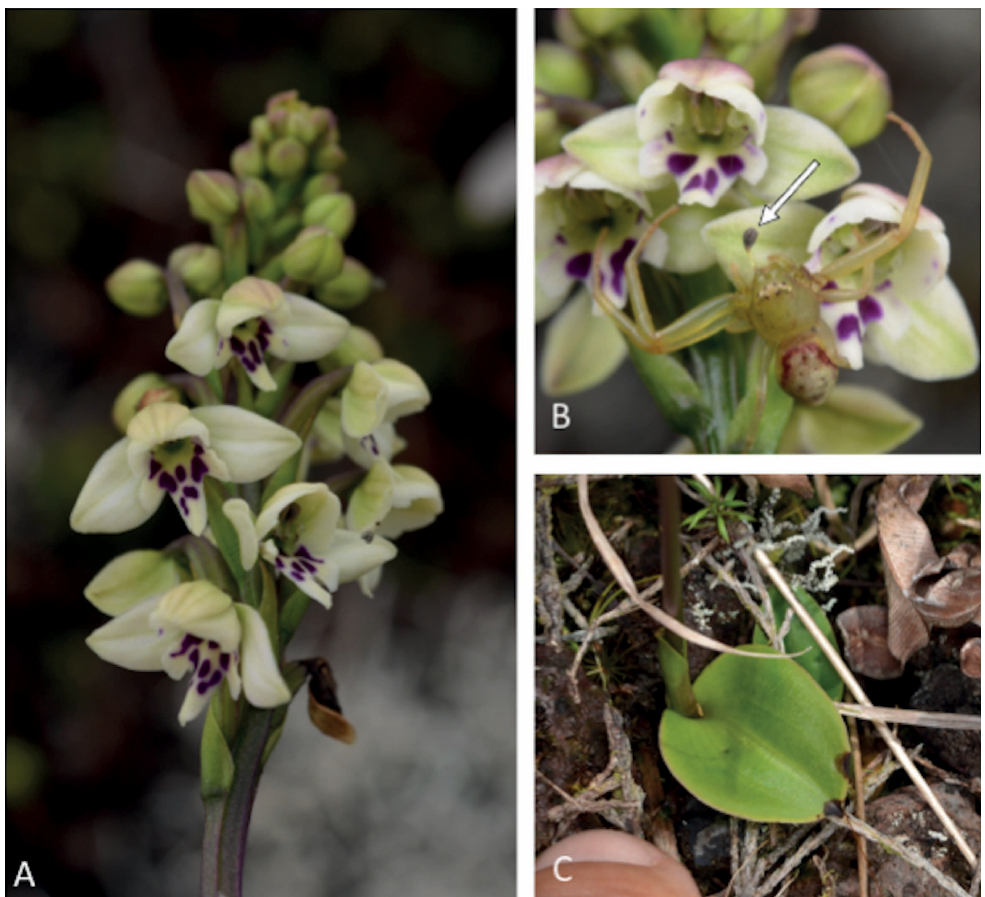
Figure 2 – Cynorkis borbonica. A . Inflorescence fleurie. B . Ledouxia alluaudi portant des pollinies de C. borbonica sur sa tête. C . Feuille